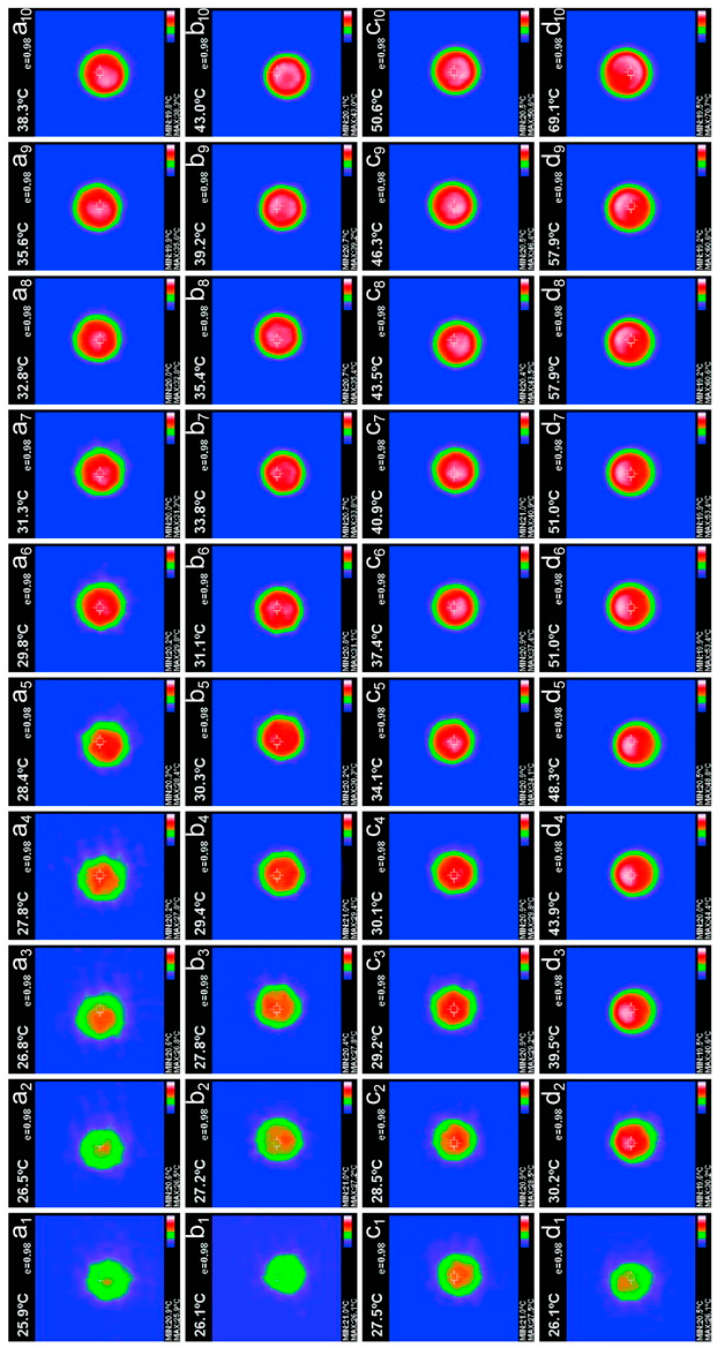
Figure 14. Infrared thermal imaging of microcapsule samples fabricated under various pH values with 5 s intervals in 50 s, (a 1 -a 10 ) M-0, (b 1 -b 10 ) M-3, (c 1 -c 10 ) M-4, and (d 1 -d 10 ) M-5.